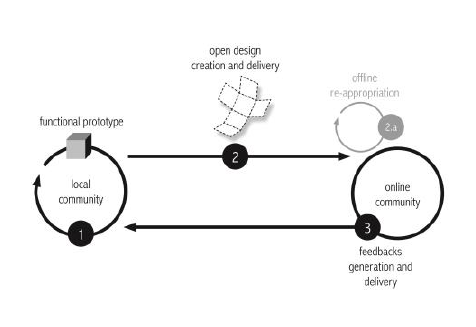
Figure 4. Design process adopted during IP